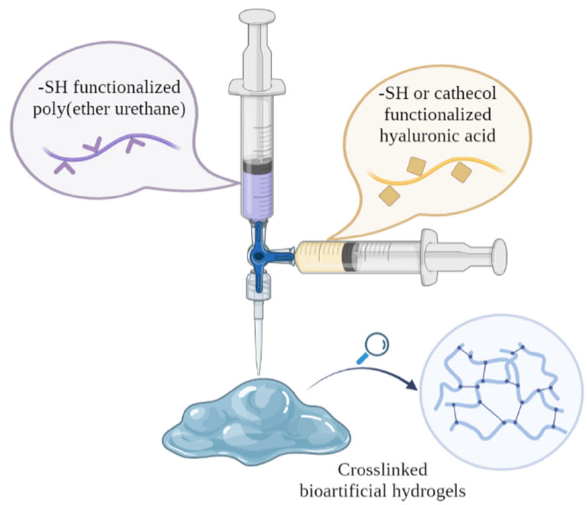
Figure 1. Schematic representation of the main concept of the work. Bioartificial hydrogels obtained by mixing a thiol- or catechol-modified hyaluronic acid with a thiol-modified poly(ether urethane) (PEU) through a luer-lock double syringe system. PEU amphiphilicity ensured system thermorespon- siveness and easy injectability, while grafted functional groups allowed fast in situ